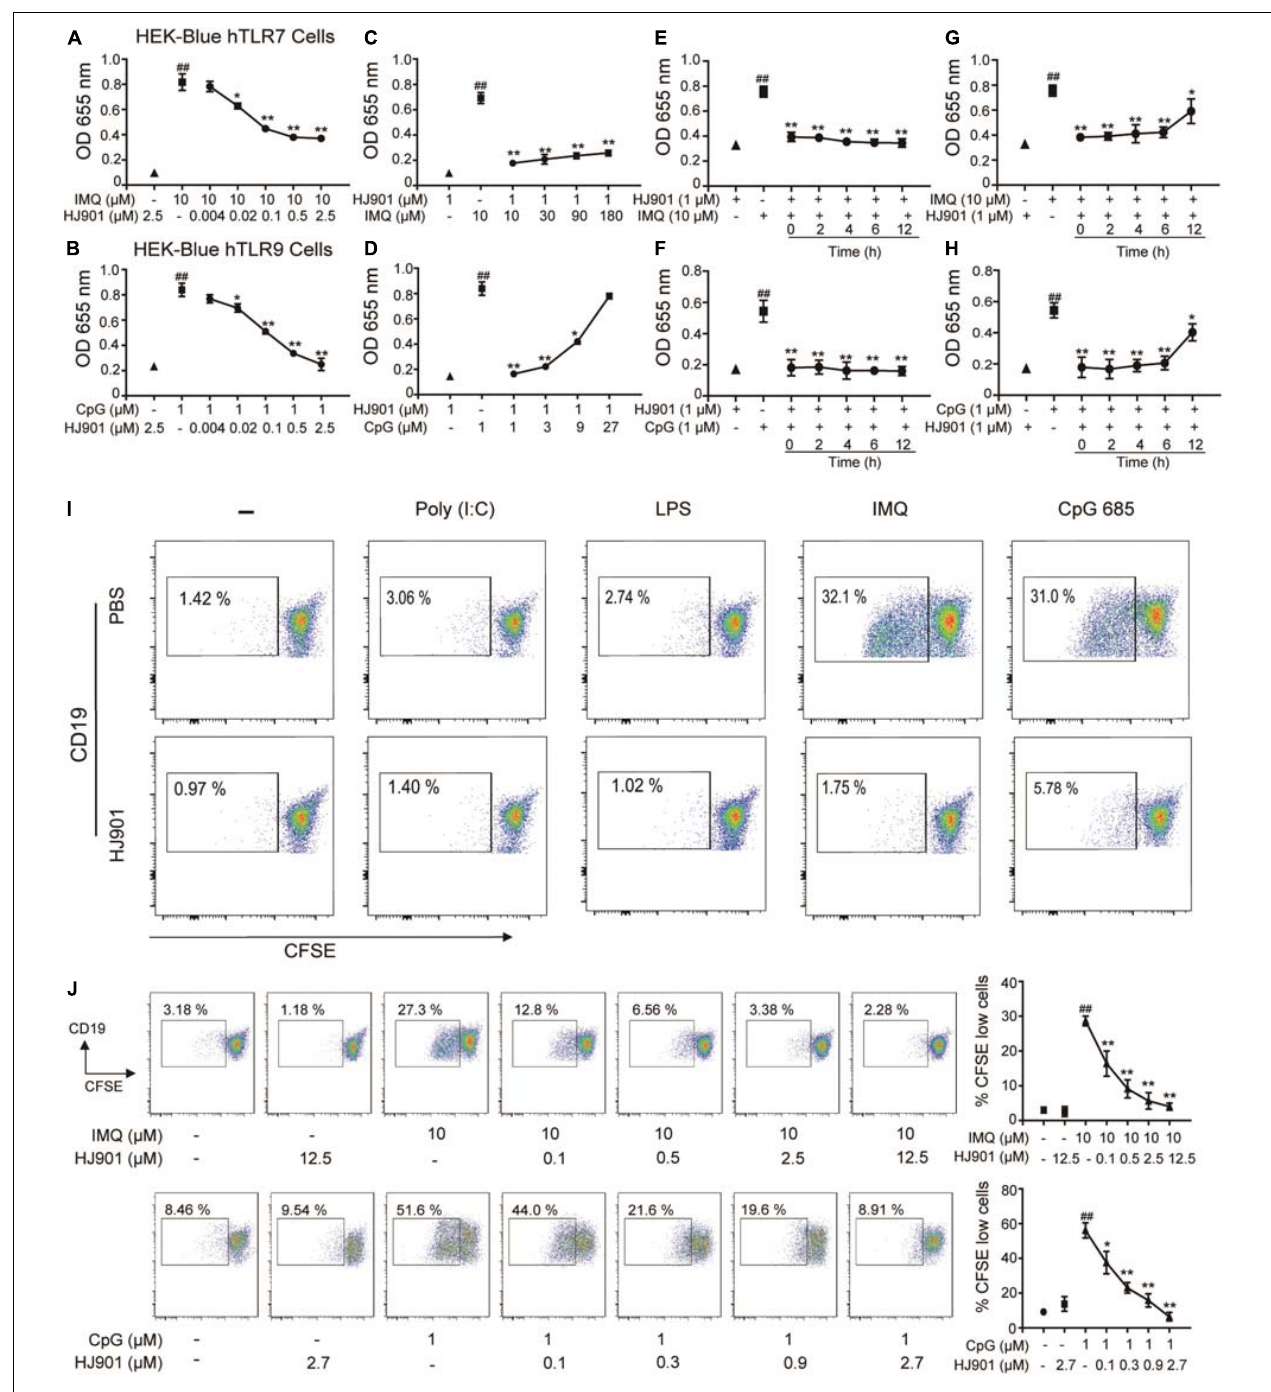
FIGURE 1 | HJ901 selectively inhibits TLR7- and TLR9-mediated cell proliferation in HEK-Blue-hTLR7, HEK-Blue-hTLR9, or PBMCs cells. (A,B) HEK-Blue-hTLR7 or HEK-Blue-hTLR9 cells were cultured with 10 µ M IMQ or 1 µ M CpG 685 (CpG) in the presence or absence of different concentrations of HJ901 (0.004, 0.002, 0.1, 0.5, or 2.5 µ M) for 24 h. (C,D) HEK-Blue-hTLR7 or HEK-Blue-hTLR9 cells were cultured with HJ901 in the presence or absence of different concentrations of IMQ (10, 30, 90, or 180 µ M) or CpG (1, 3, 9, or 27 µ M) for 24 h. (E,F) HEK-Blue-hTLR7 or HEK-Blue-hTLR9 cells were incubated with HJ901 for 0, 2, 4, 6, or 12 h and then treated with or without 10 µ M IMQ or 1 µ M CpG HJ901 for 24 h. (G,H) HEK-Blue-hTLR7 or HEK-Blue-hTLR9 cells were incubated with 10 µ M IMQ or 1 µ M CpG for 0, 2, 4, 6, or 12 h and then treated with or without HJ901 for 24 h, and the SEAP activity was determined. (I) Human PBMCs incorporated CFSE cultured with Poly (I: C), LPS, IMQ, or CpG in control ODN, and HJ901 cells for 5 days of treatment. (J) Human PBMCs incorporated CFSE cultured with IMQ or CpG in the presence or absence of different HJ901 concentrations for 5 days. Proliferation of CD19 + B cells was determined by CFSE dilution, which was assessed by flow cytometry. Quantification of three experiments is shown in the right panel. Similar results were obtained from three independent experiments. All data are presented as the means ± SEM ( n = 5 in each group). ## p < 0.01 vs. the untreated group or HJ901 group; * p < 0.05 and ** p < 0.01 vs. the IMQ or CpG group.